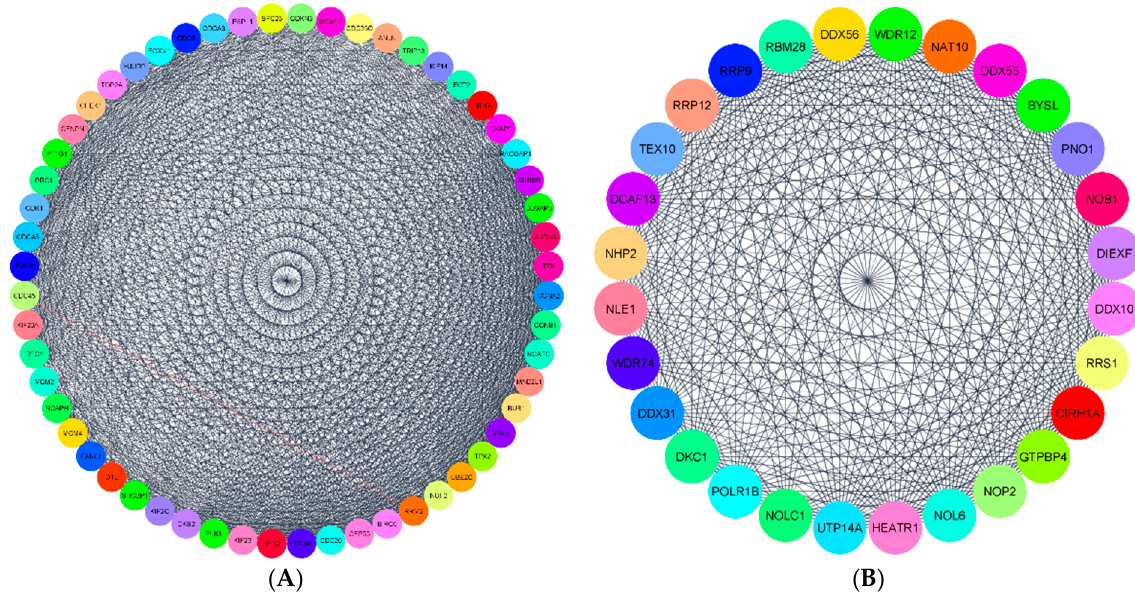
Figure 7. ( A , B ) The most significant modules of DEGs in G2. Cluster1 and Cluster2 were obtained with the MCODE plugin in Cytoscape.